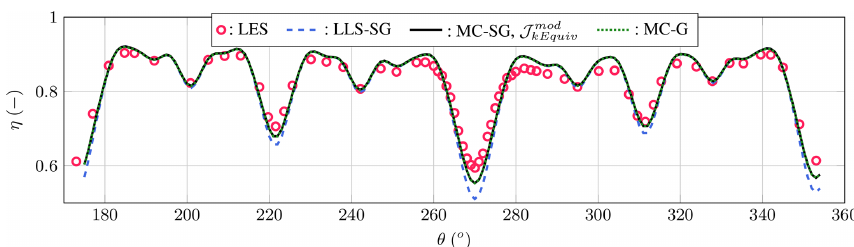
Figure 4. Comparison of the normalized Horns Rev wind farm power output based on LES simulations from Porté-Agel et al. (2013), the LLS method together with the super-Gaussian model (LLS-SG), the momentum-conserving method together with the super-Gaussian model (MC-SG), and the momentum-conserving method together with the Gaussian model (MC-G).